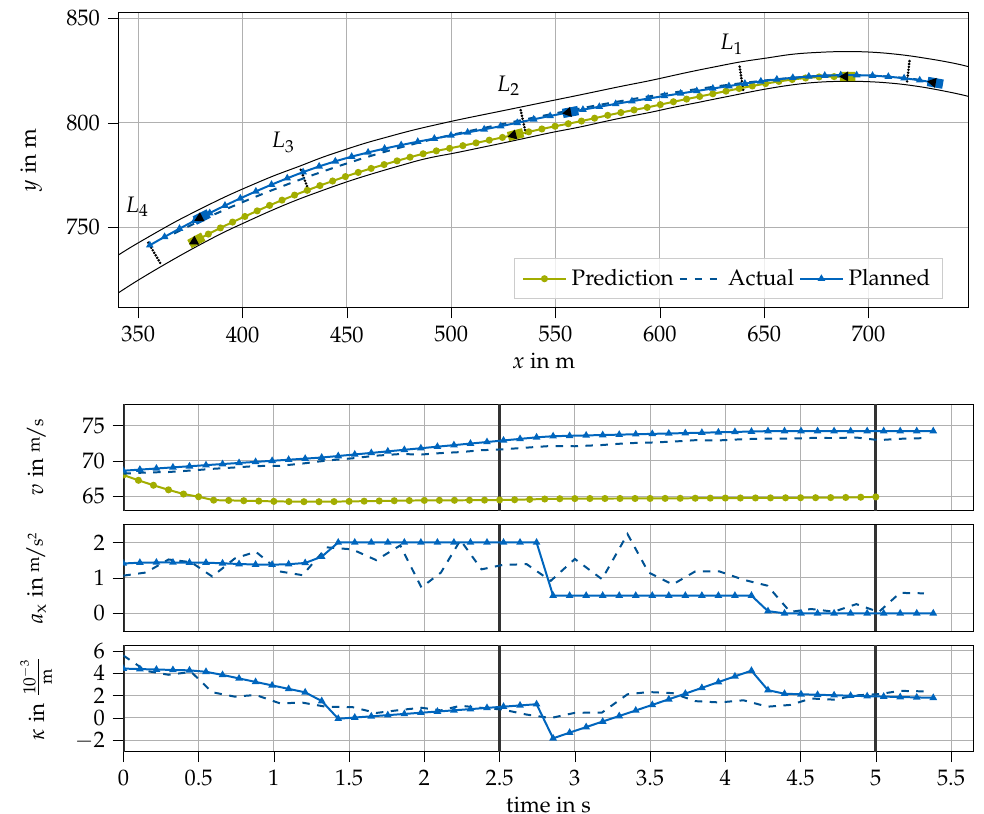
Figure 6. Initiation of an overtaking maneuver in planning step d (cid:13) . The planned and actually driven path, velocity, acceleration, and curvature are shown in blue. The correctly predicted path and velocity of the defender are green. The planned and predicted poses of the vehicles are shown for t = 0 and the times marked by the vertical lines in the lower